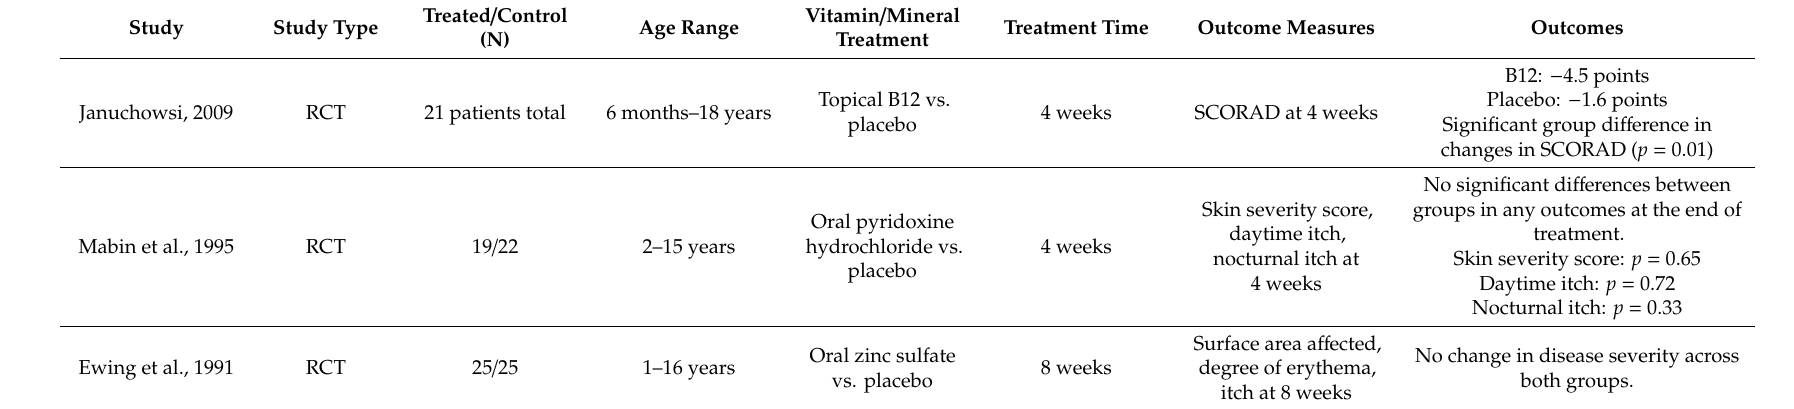
Table 3. Vitamins and minerals for the treatment of pediatric atopic